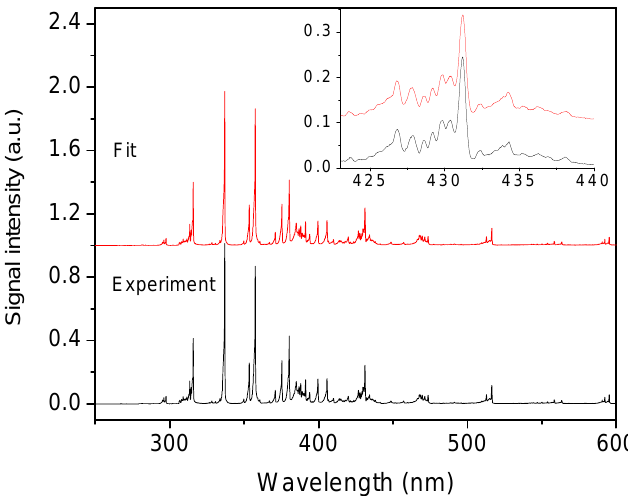
Figure 3. Filament-induced fluorescence spectrum of air containing 1,316 ppm of C with the fit spectrum by a genetic algorithm under the assumption and 5,263 ppm of CH 4 that the trace species and concentrations in the mixture are unknown. The fit spectrum is shifted in order to facilitate the observation. The inset shows part of the experimental and fitting spectra in a higher resolution. The calculated concentrations of acetylene and methane are 1,592 and 6,342 ppm, respectively. The spectra shown in Figure 3 come from the mixture of air, C H and CH . Some spectral lines such as CH result both from C 2 2 4 and CH 4